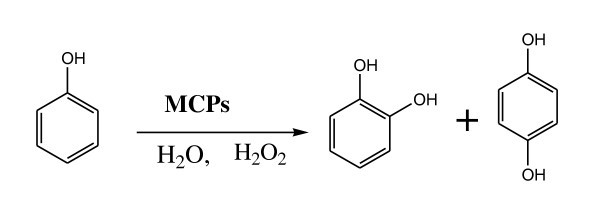
Catalytic phenol hydroxylation by H2O2.